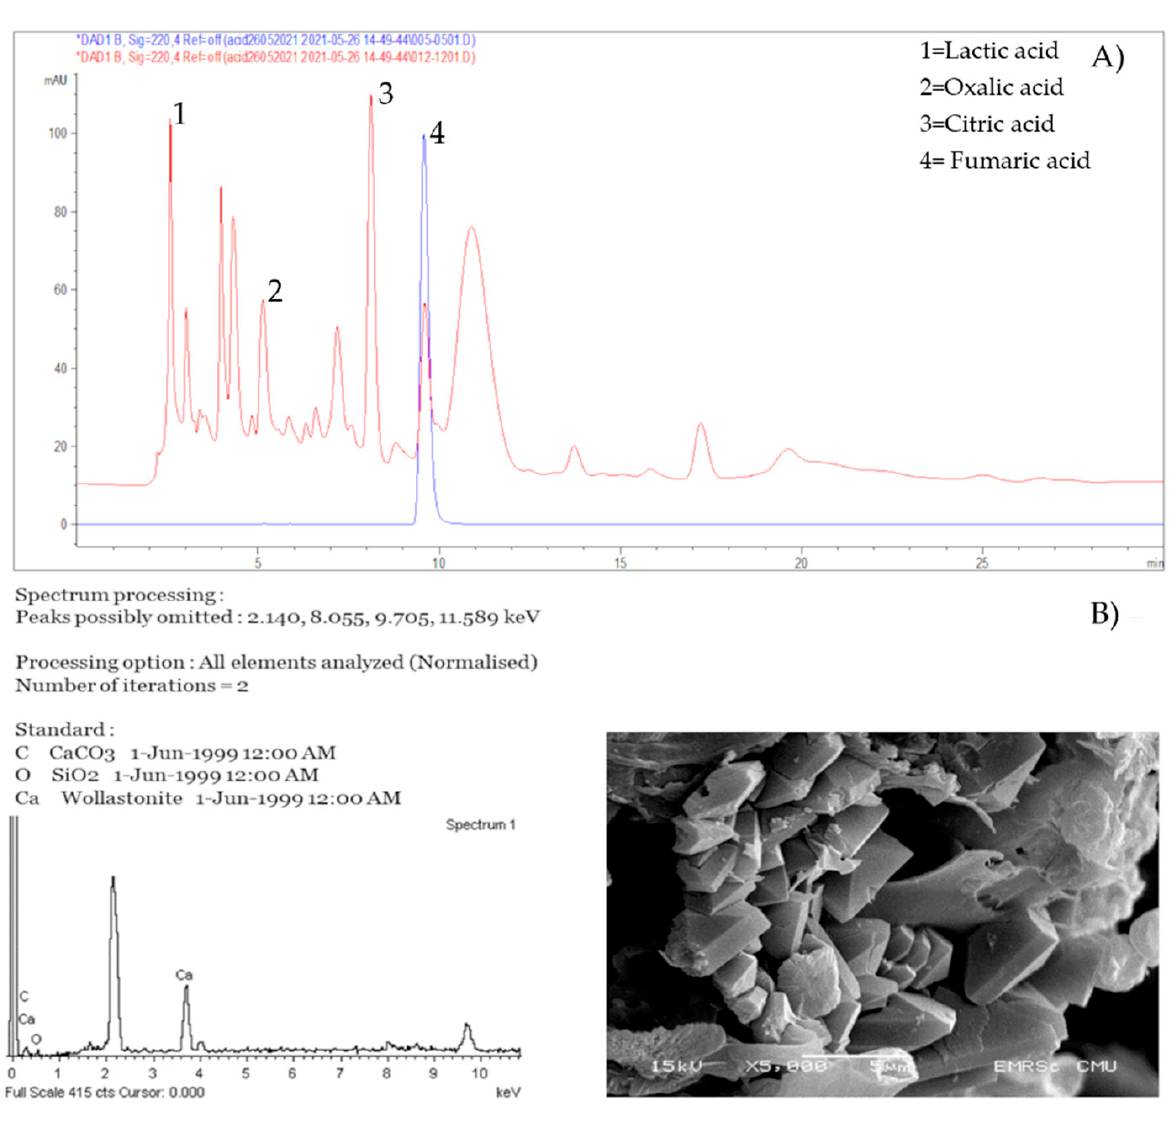
Figure 3. Acid production of Aspergillus fumigatus (red peak) compared with fumaric acid standard (blue peak) ( A ) and Calcium formation and EDS analysis of Aspergillus piperis ( B ). As the ability to form calcium is indicative of the ability to cause staining on and damage paintings [64–67], all fungal isolates from both temples were also tested for their calcium formation using scanning electron microscope. None of bacterial isolates could precipitate calcium carbonate. On the other hand, 2 fungal isolates could form calcium crystal on B4 agar Table 1. The isolates were identified to be A. niger and A. piperis . Both fungal isolates had the same calcium oxalate crystal structure as shown in Figure